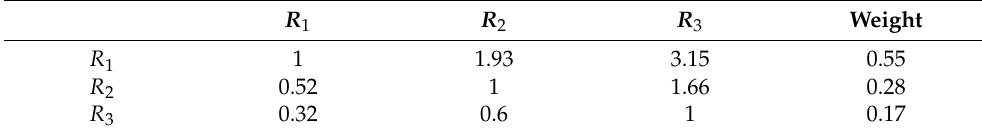
Table 4. Weight judgment matrix of ROM.